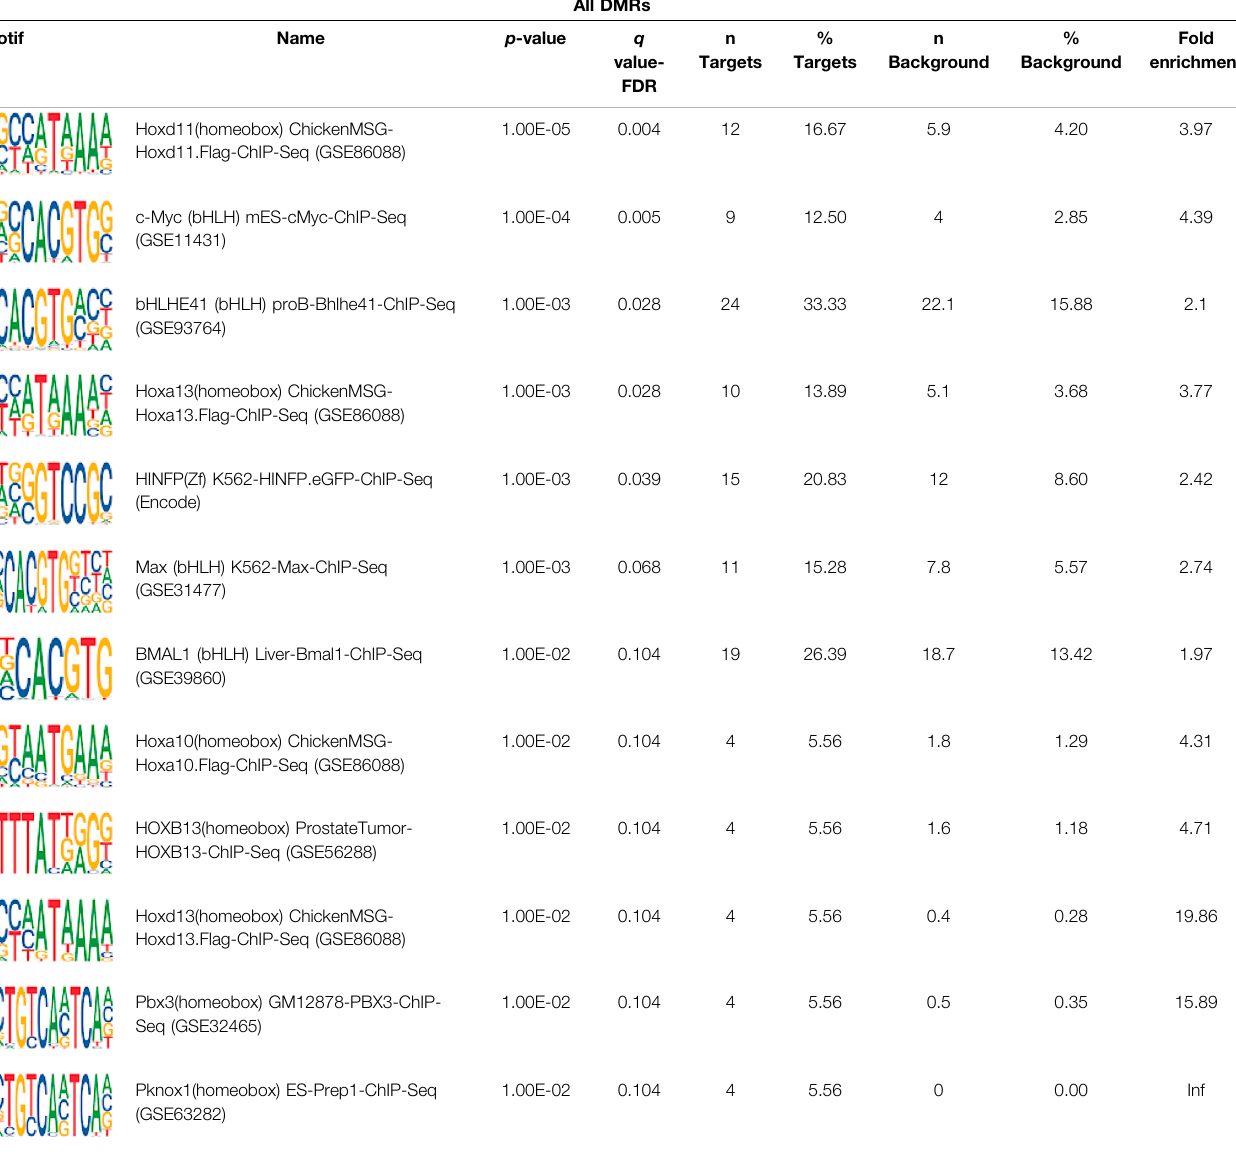
TABLE 2 | Homer TFBS Motif enrichment results for all DMRs comparing TSBAVvs. TS TAV indicating PBX3 and PKNOX1 approach statistical signi fi cance ( q value <